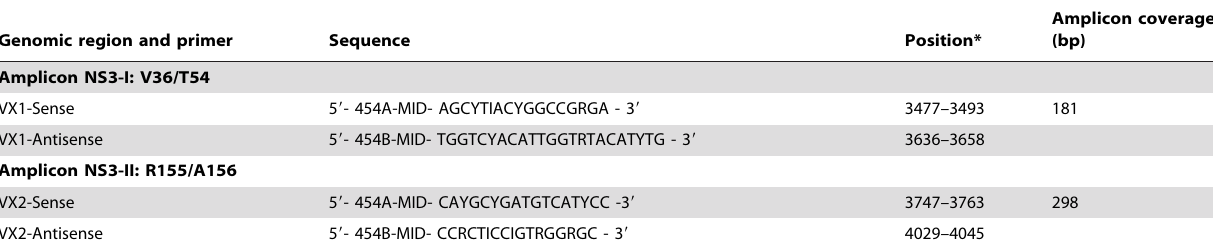
Table 2. HCV NS3-specific UDPS-primers.